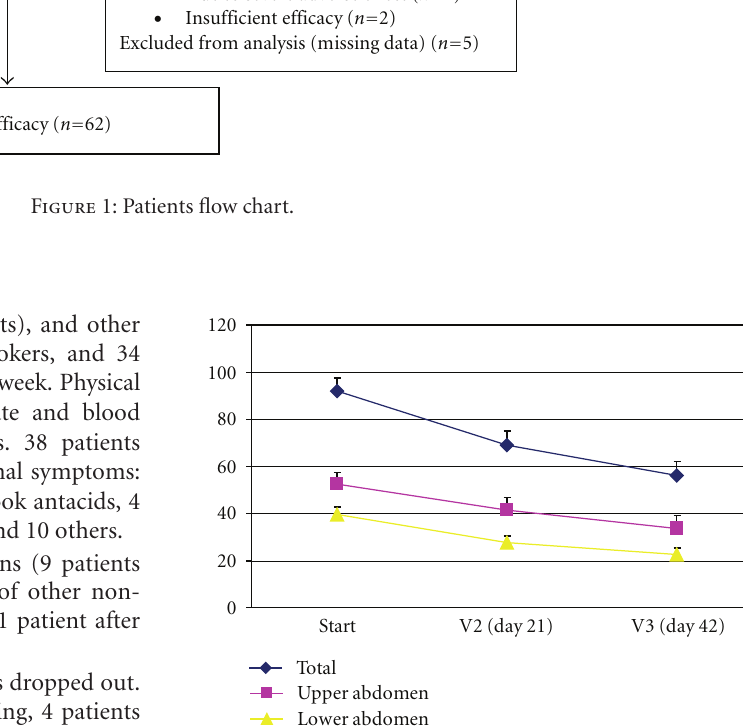
Figure 2: Mean of total symptom score, upper abdomen score, and lower abdomen score in the course of the study: standard error of the mean ( n =